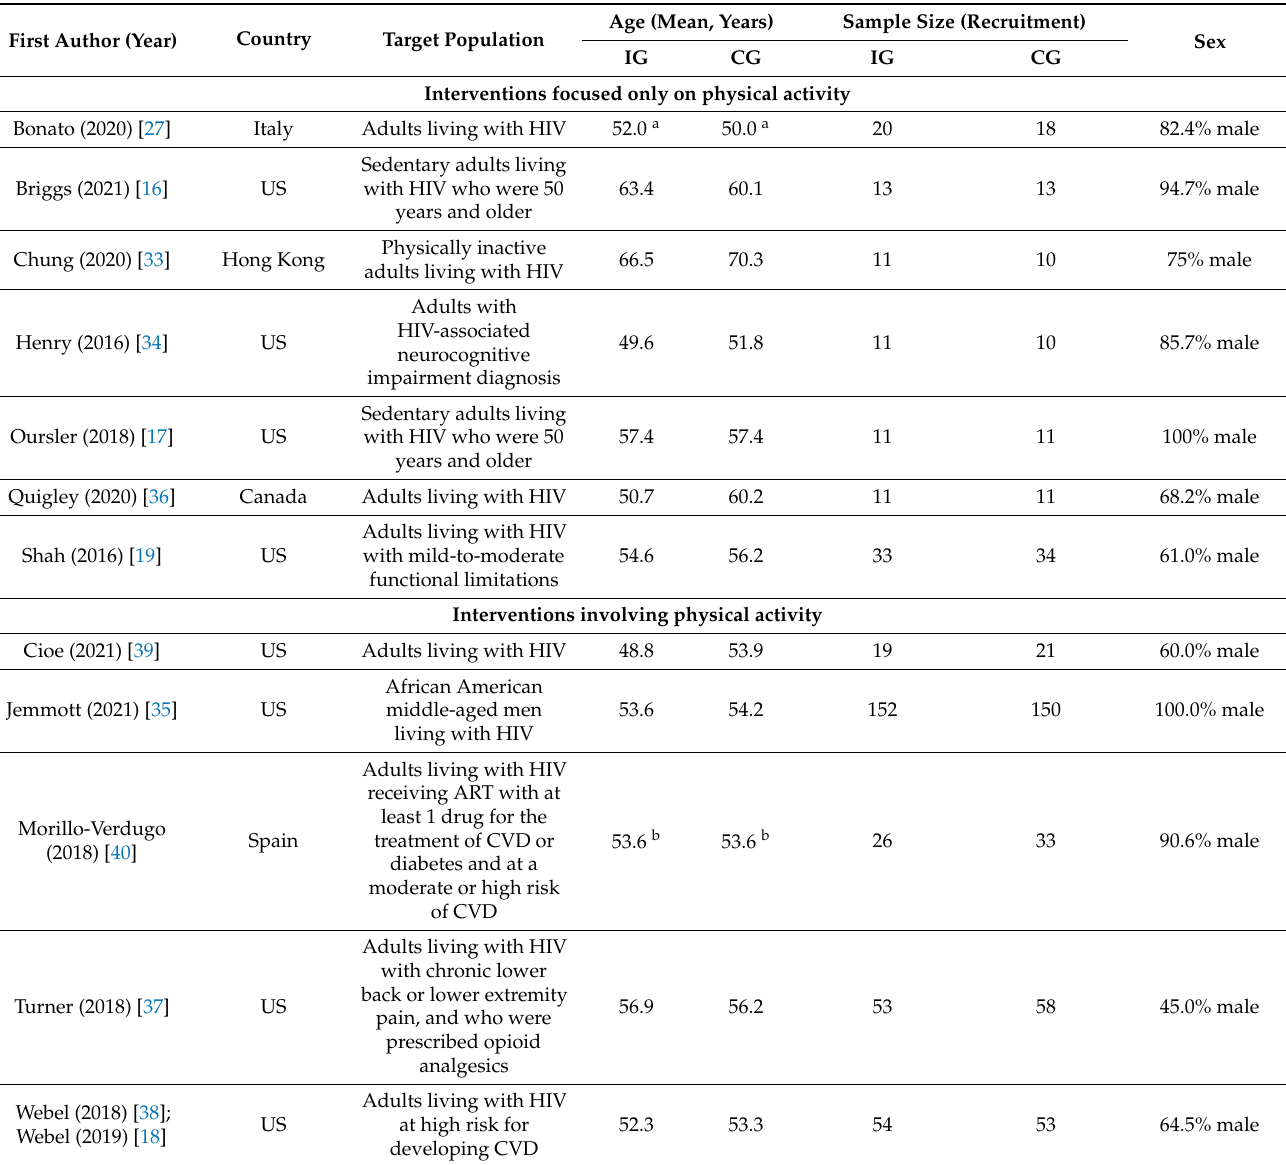
Table 1. Characteristics of studies selected for the systematic review and meta-analysis on people aged ≥ 50 years with